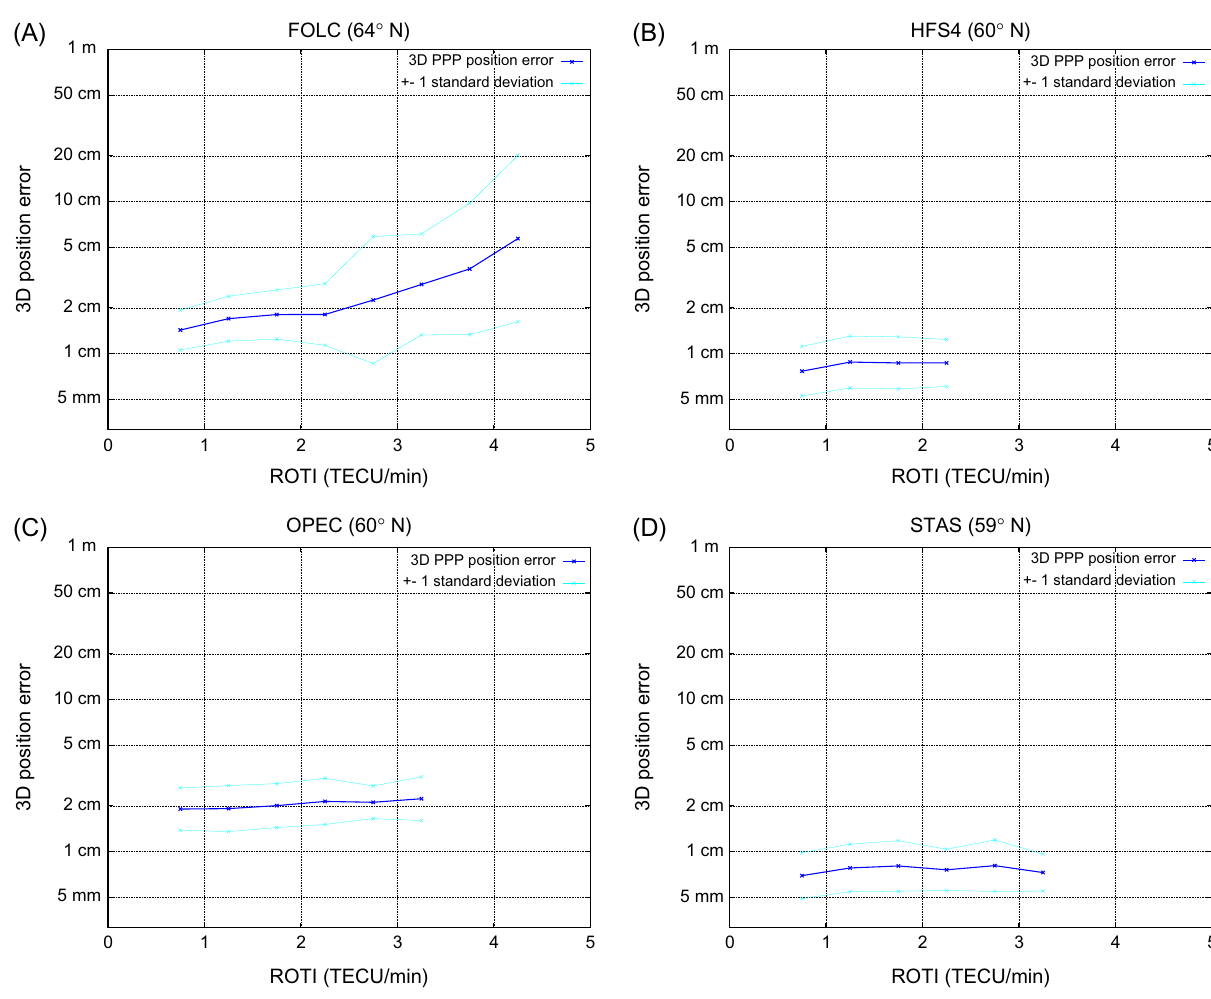
Fig. 4. Statistical relationship between mean ROTI and 3D position error, for these receivers: (A) FOLC, (B) HFS4, (C) OPEC, (D)